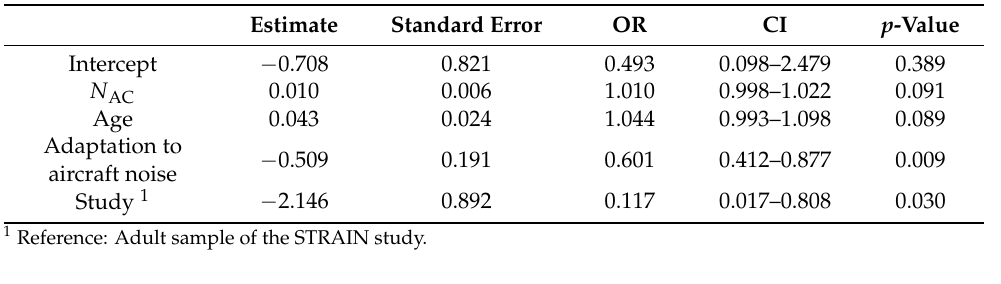
Figure 5. Forest plot depicting the OR and 95% CI for children ( N = 48, red) and adults from the STRAIN study ( N = 48, blue) for the acoustical and non-acoustical predictors of annoyance in model LR4.